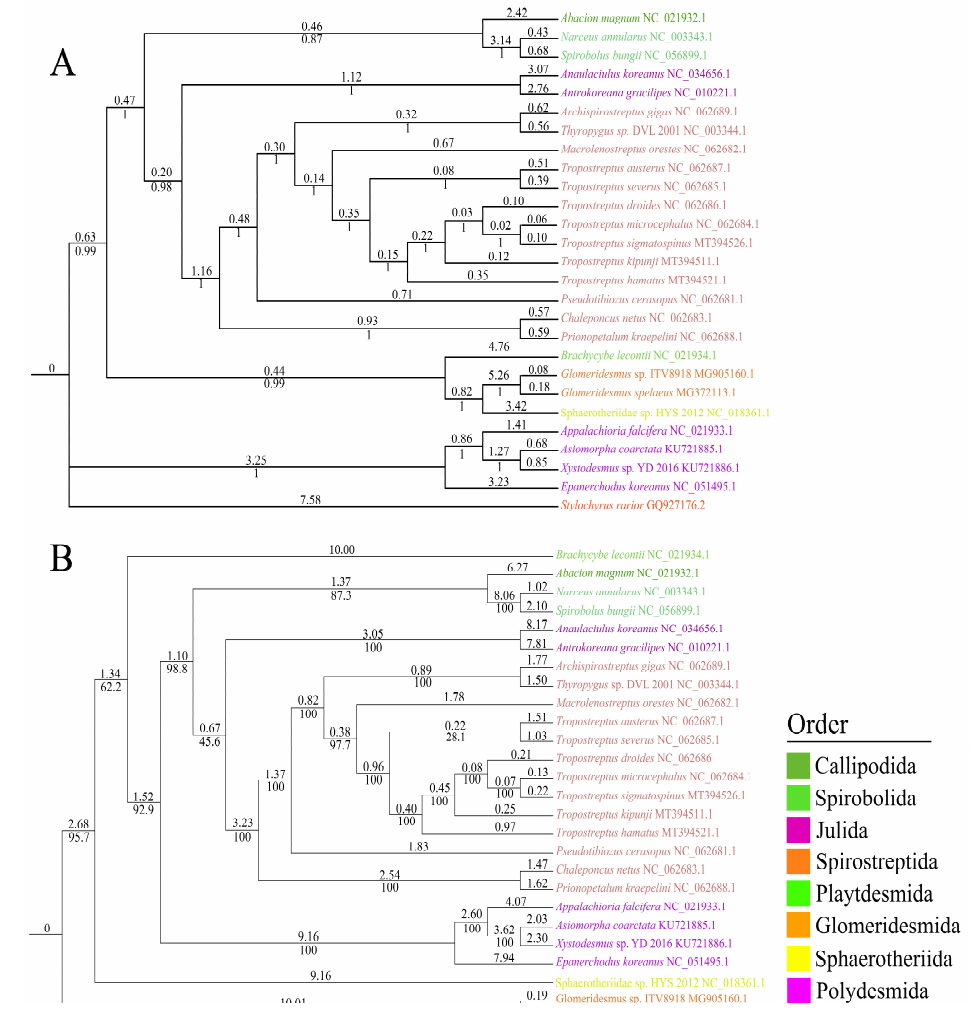
Figure 5. Mitogenomic phylogeny of 26 Diplopoda species and an outgroup ( Stylochyrus rarior ) based on 13 PCGs using Bayesian inference ( A ) and maximum likelihood ( B ) methods. The same colors of species in the tree indicated the same order.